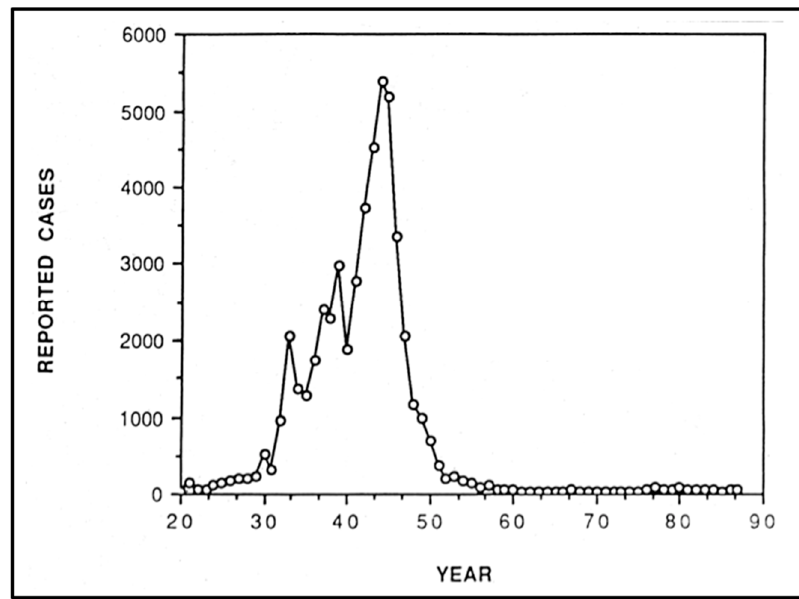
Figure 12. Flea-borne typhus fever cases in the United States, 1920–1987 [1].